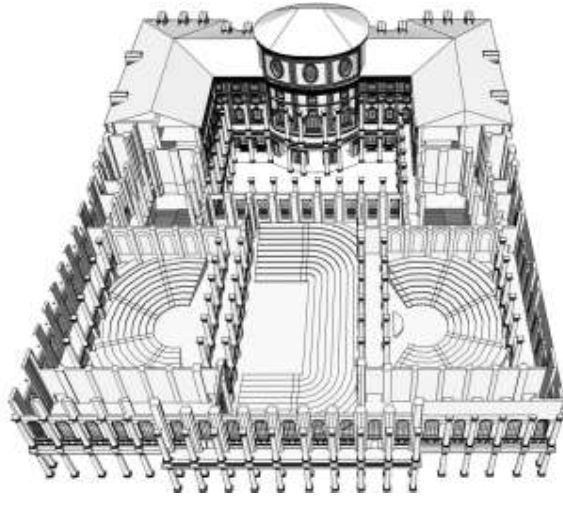
Figure 9. 3D Model of National Parliament project by